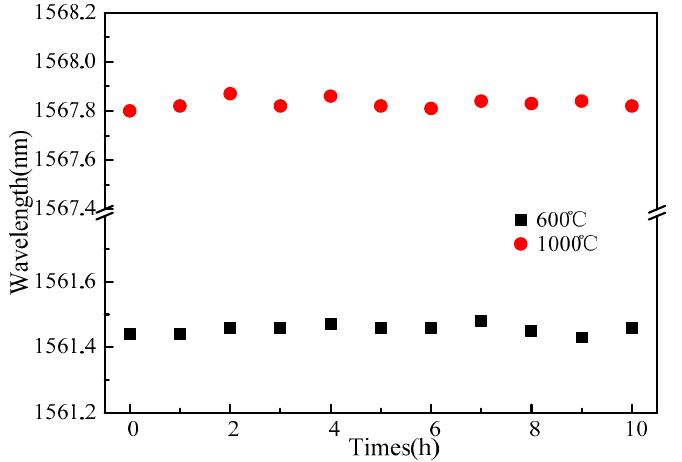
Figure 9. Temperature stability experiment.